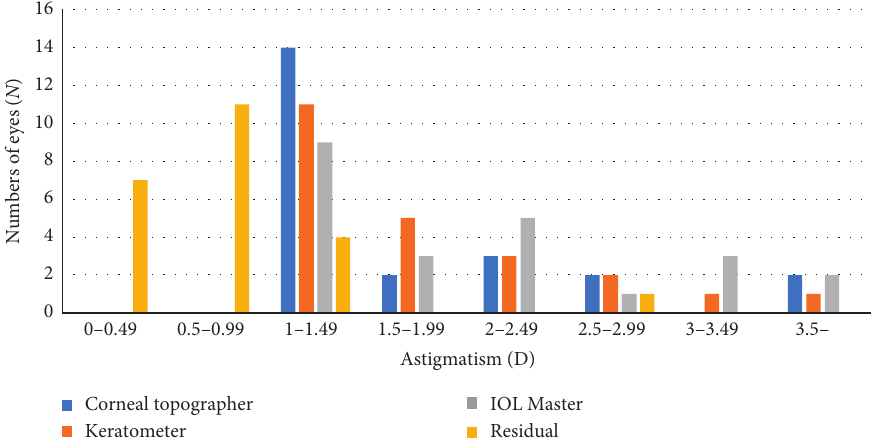
Figure 6: Distribution of corneal astigmatism preoperatively and residual astigmatism 3 months